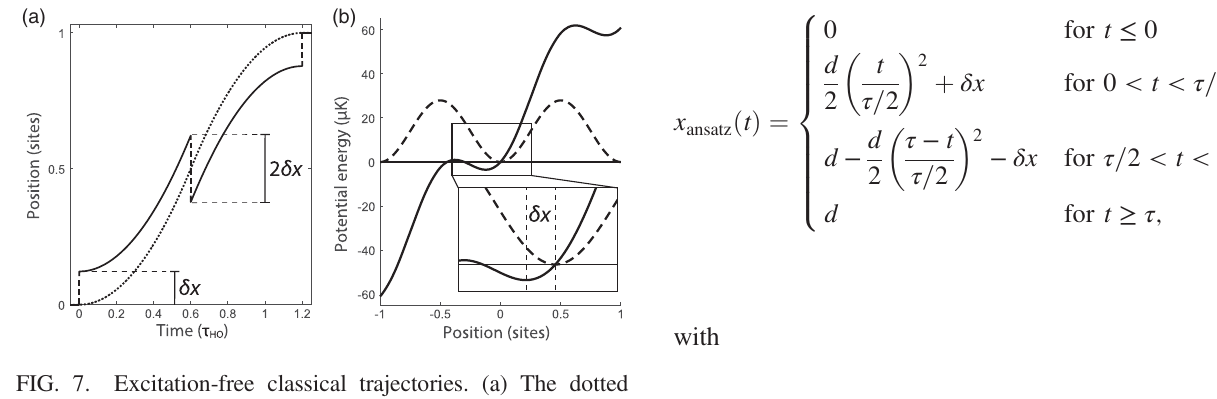
FIG. 7. Excitation-free classical trajectories. (a) The dotted curve shows the trajectory of a classical point particle being first constantly accelerated and then decelerated. The solid curve is the t Þ , see Eq. (G2), required to drive the trajectory of the trap x ansatz ð particle along the dotted curve. The example refers to τ ¼ 1 . 2 τ HO and d ¼ λ = 2 , whereas δ x is given by Eq. (G3). (b) The potential in the noninertial comoving frame (solid curve) is equal to the static potential (dashed curve) plus a linear tilt with slope m ̈ x t Þ . The sudden shift by δ x keeps the particle at the ansatz ð position of the potential minimum in the comoving frame, avoiding motional excitations (e.g., slosh